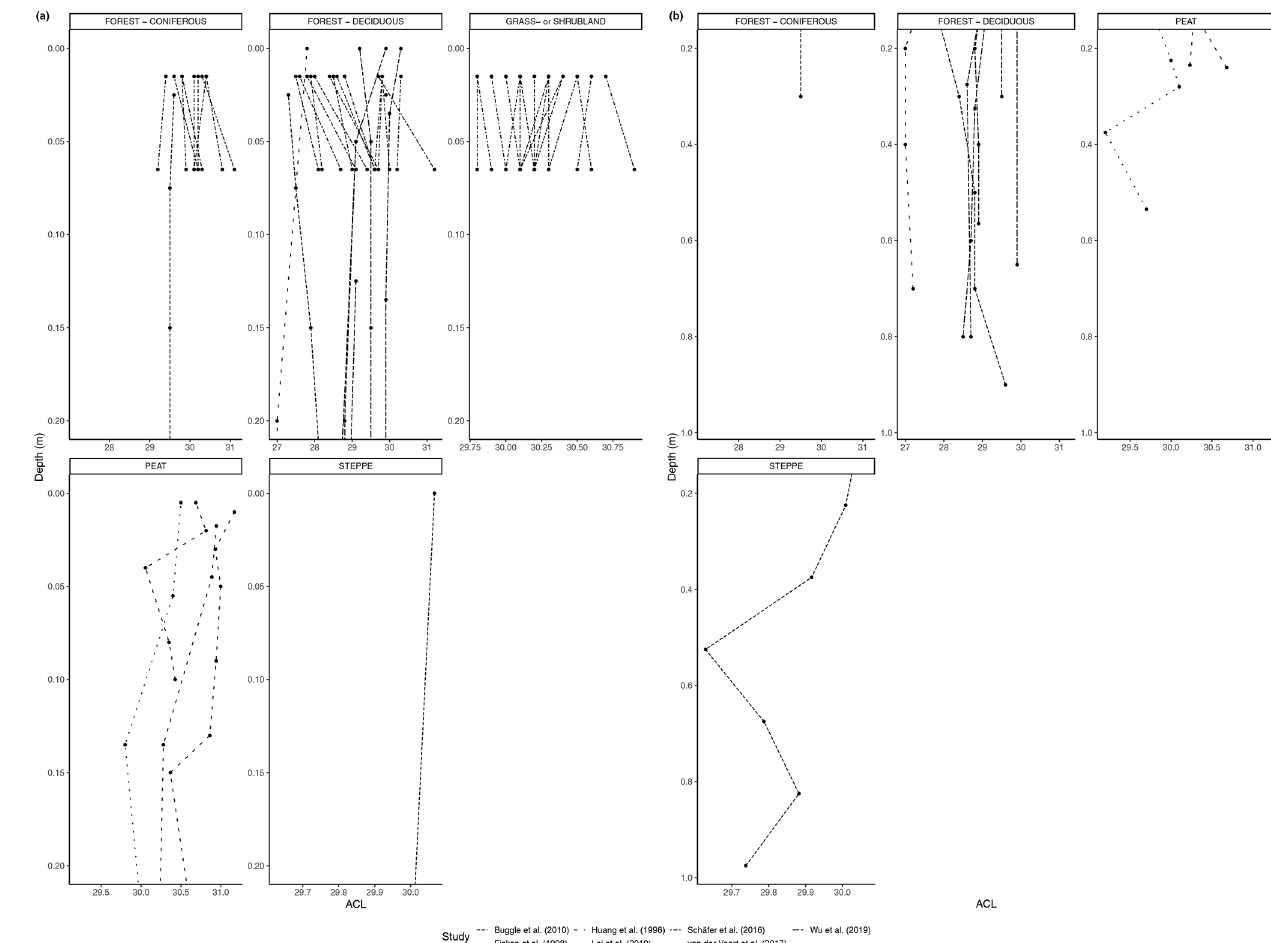
Figure 7. (a) ACL of n -alkanes in soil from 0 to 20cm. (b) ACL of n -alkanes in soil below